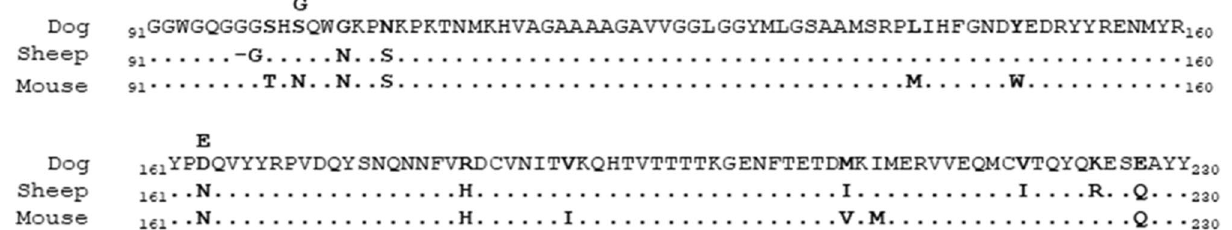
Figure 4. Dog, mouse and sheep PrP sequence alignment. PrP amino acid alignment from residue 91 to 230 of dog PrP from dog, sheep and mouse species. The dog amino acids that are different in the other two species are indicated in bold. Accession numbers: dog PrP (FJ870767.1); ovine PrP (NP001009481.1) mouse PrP